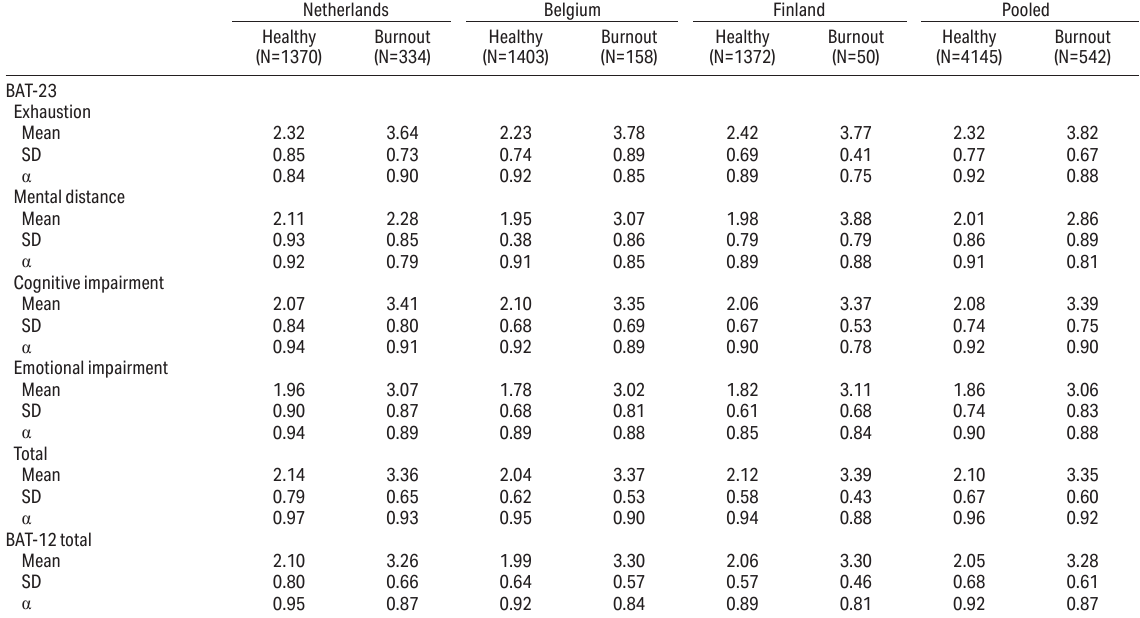
Table 1. Burnout Assessment Tool (BAT) means, standard deviations (SD) and internal consistencies across countries and healthy and burnout samples [SD=standard deviation; α =Cronbach alpha].